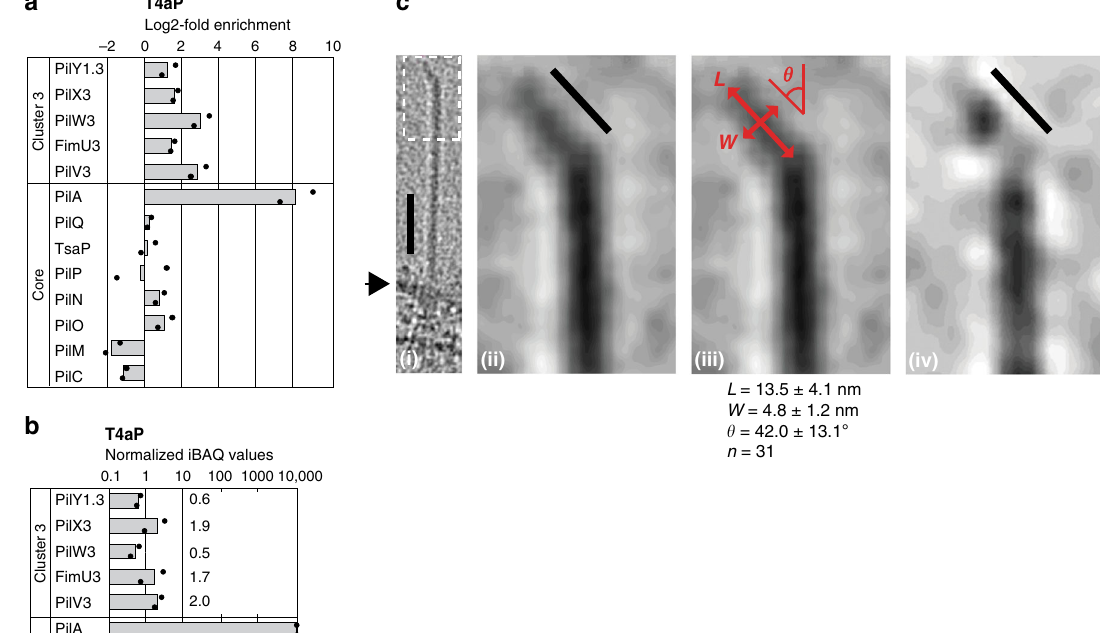
Fig. 5 Minor pilins and PilY1 are present in T4aP. a Cluster_3 minor pilins and PilY1.3 are enriched in puri fi ed T4aP. T4aP were puri fi ed from the hyper- piliated Δ pilT mutant and the non-piliated Δ pilB Δ pilT mutant (negative control). Samples from two biological replicates were analyzed by LFQ-MS, mean iBAQ values were determined, and log2-fold enrichment in Δ pilT samples compared to the negative control was calculated. For PilW3, enrichment was calculated using imputed values. Columns represent mean of log2-fold enrichment ( n = 2), dots represent the corresponding data points. b iBAQ values from negative control were subtracted from iBAQ values of the Δ pilT samples from a ; subsequently, these values were normalized relative to an iBAQ value of 10,000 for PilA in the Δ pilT sample. The columns represent the mean of normalized IBAQ values ( n = 2), dots represent the corresponding data points. c Cryo-ET images of T4aP tip structures. First panel, T4aP extending from cell surface (arrow) and with the kinked structure at the tip; scale bar, 50 nm. Second panel, magni fi cation of area in stippled box in fi rst panel illustrating kinked structure without a density gap; scale bar, 10 nm. Third panel, the same pilus tip image as in the second panel, with double-headed arrows indicating the directions of length ( L ), width ( W ), and kink angle ( θ ) measurements. The result of measurements on the 31 available T4aP tip is listed underneath the panel (mean ± standard deviation). Fourth panel, kinked tip structure with a density gap between terminal globular density and the tip of the pilus shaft; scale bar, 10